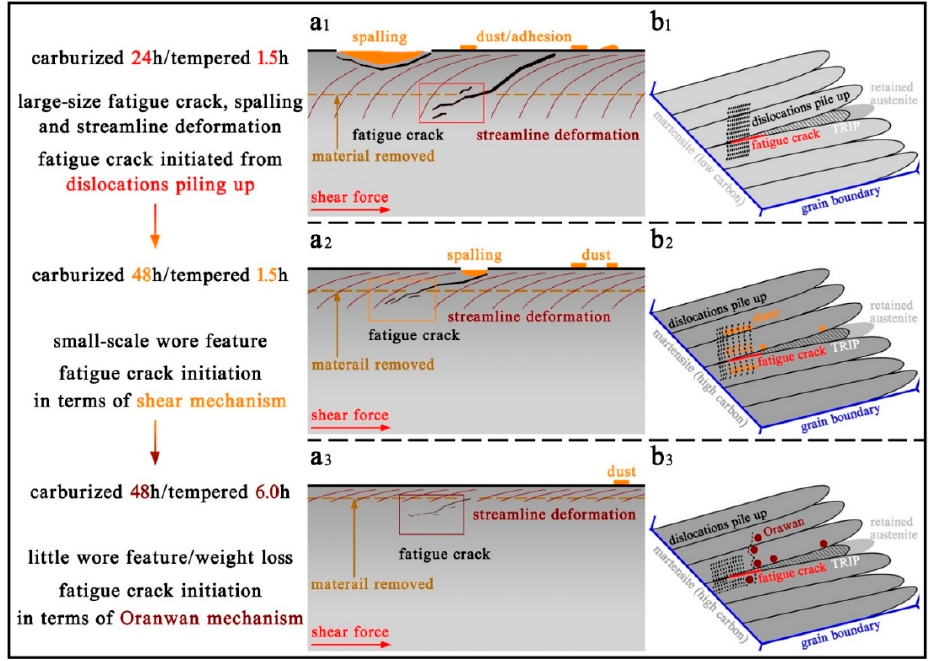
Figure 7. Fatigue-wear model corresponding to the specimens processed with different carburiz- ing/tempering durations; ( b 1 – b 3 ) is the magnified map of the selected region in ( a 1 – a 3 ). ing/tempering durations; ( b1 – b3 ) is the magnified map of the selected region in ( a1 – a3 During the initial period, severe wear is generated on rough surfaces with increasing